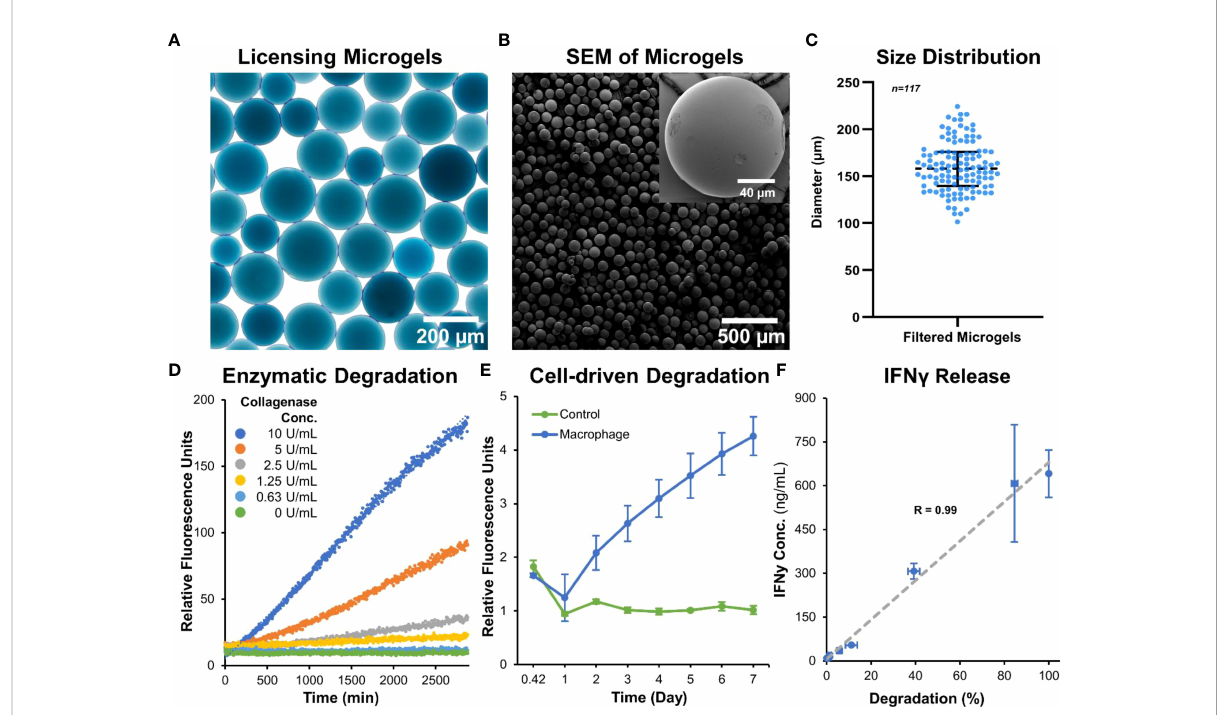
FIGURE 2 Microgel fabrication and characterization. (A) Bright- fi eld image of sorted microgels show homogenous size distribution. (B) Scanning electron micrographs of dehydrated microgels show smooth surface and spherical morphology. (C) Size distribution of hydrated microgels. (D) Microgels exhibit a concentration-dependent degradation when incubated with collagenase solution. (E) A time-dependent degradation was seen when cultured with macrophages. (F) The release rate of IFN g linearly correlated with the enzymatic-degradation of microgels (n =